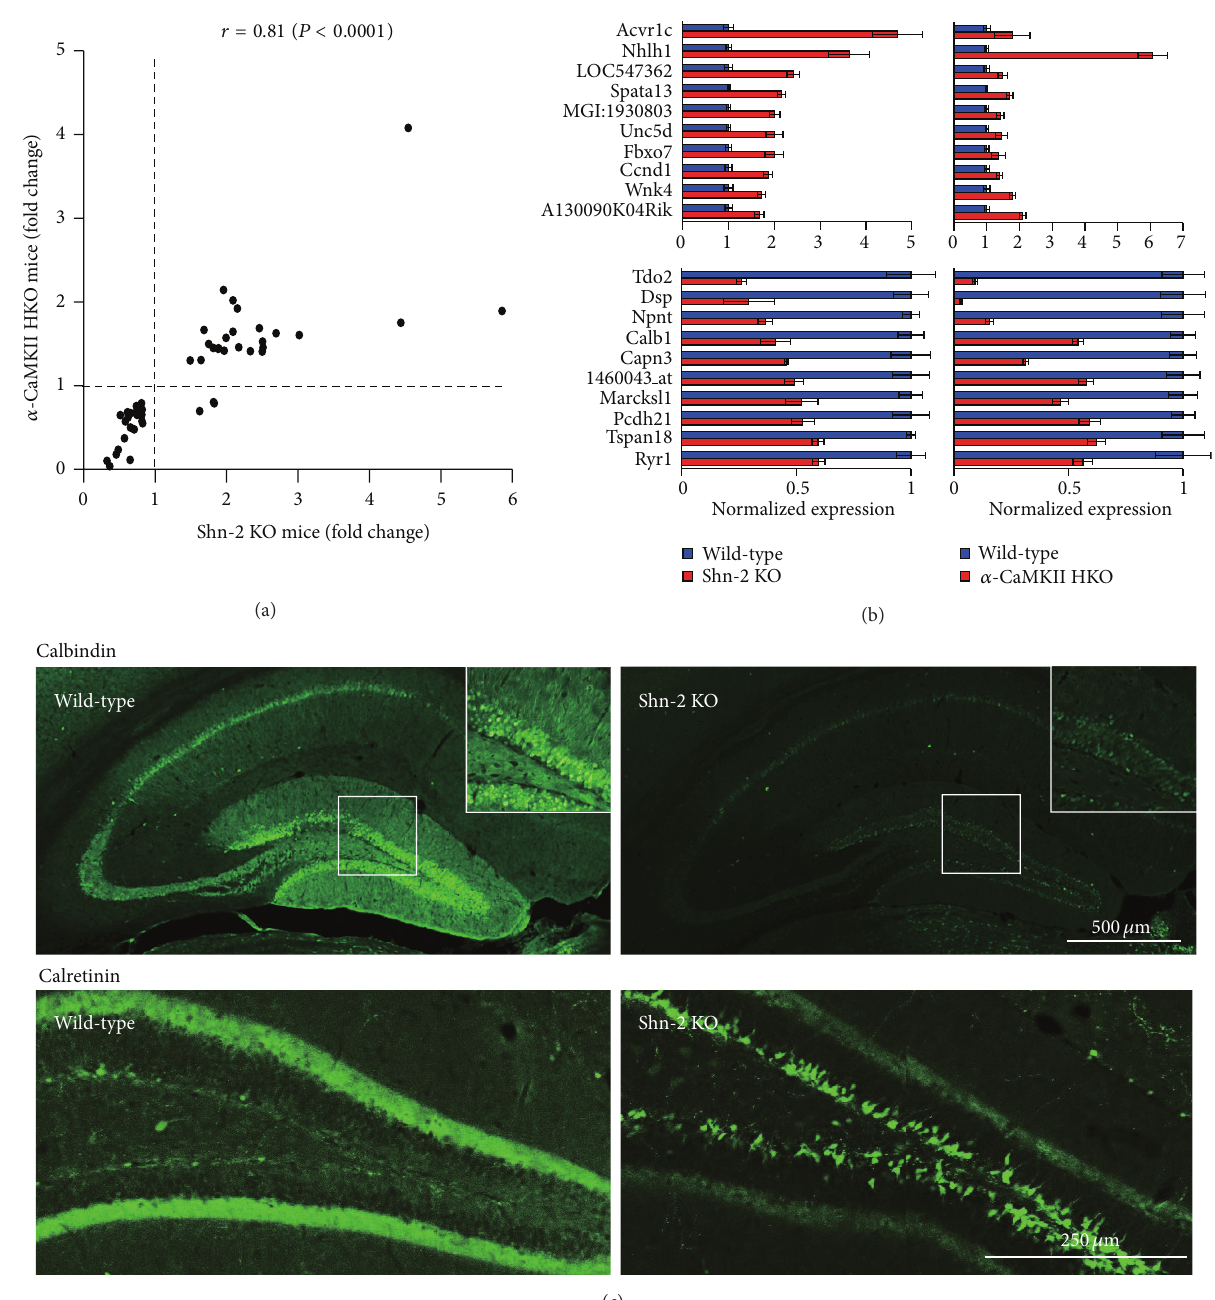
Figure 4: Maturation abnormalities in DG neurons of Shn-2 KO mice. (a) The hippocampal transcriptome pattern of Shn-2 KO mice is similar to that of 𝛼 -CaMKII HKO mice, which also demonstrated maturation abnormalities in the DG. Genes showing differential expression between genotypes at 𝑃 < 0.005 in both experiments were plotted. (b) Normalized gene expression of differentially expressed genes in Shn-2 KO and 𝛼 -CaMKII HKO mice. The top 10 genes are indicated in the graphs. (c) Expression of the mature neuronal marker calbindin was decreased, and the expression of the immature neuronal marker calretinin was markedly increased in the DG of Shn-2 KO mice. Adapted from Takao et al.